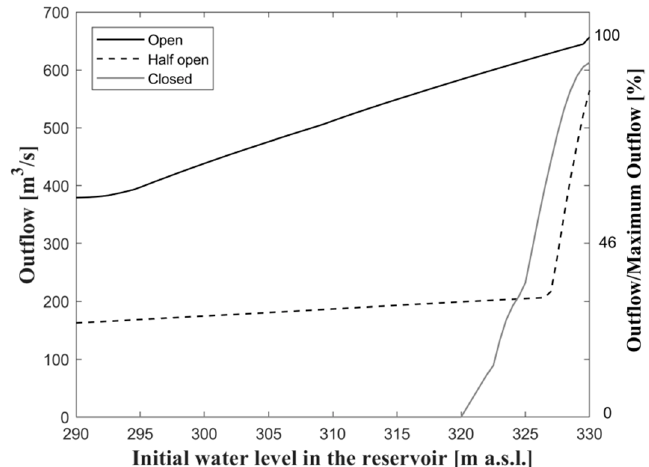
Figure 7. Discharge outflowing from the dam in absolute value (left axis) against the initial level in the reservoir for the three opening of the outlet gate (i.e., open, half open and closed). The outflow is compared with the maximum possible outflow and the value is reported in percentage (right axis).